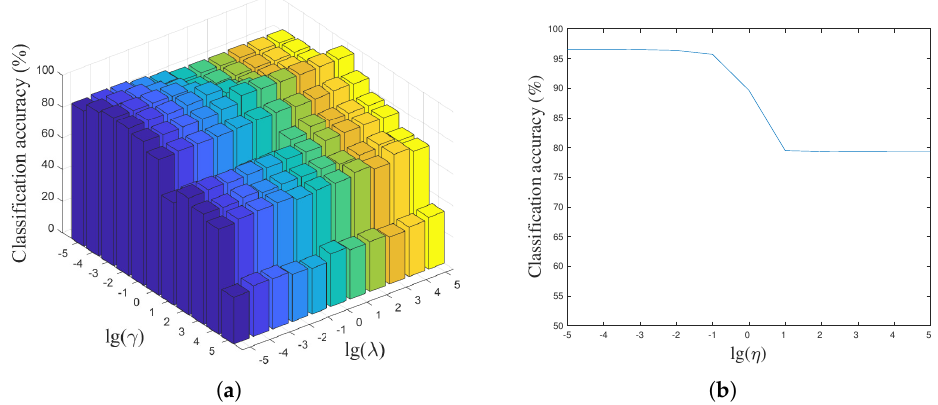
Figure 6. The classification accuracy versus parameters λ , γ and η on the Yale face dataset; ( a ) parameter η is fixed; ( b ) parameters λ and γ are